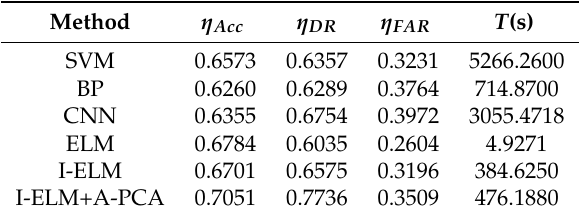
Table 15. The values of evaluation criteria of different detection algorithms (UNSW-NB15).